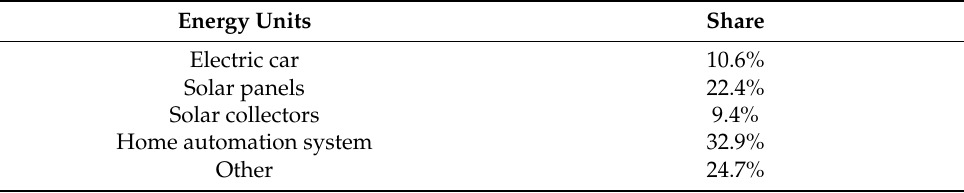
Table 6. Energy units use in respondents house.